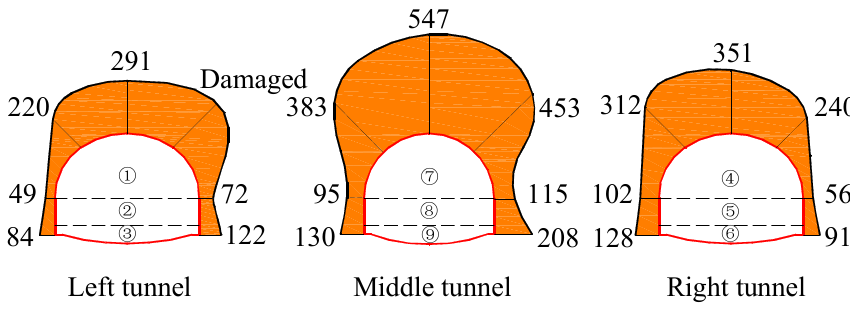
Figure 7. Distribution of surrounding rock pressure at section DK68 + 220 (Unit: kPa).